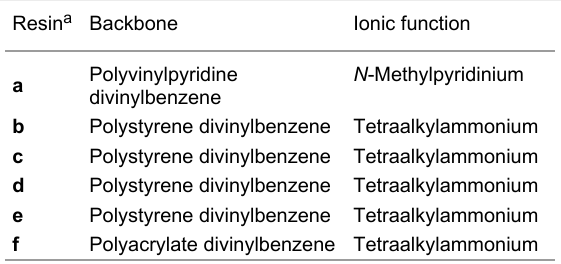
Even in batch processes it was possible to remove more than 90% of dissolved 1 from the model solution which indicates that strong interactions between the resins and the adsorptive phase takes place. Desorption of the product can easily be performed by acidic treatment of the loaded resins. The most AcOH (ratio 8:2). This treatment leads to protonation of vanil- late anions adsorbed at the resin and ionic interactions between the resin and the product vanish. The remaining interactions between vanillin ( 1 ) and the aromatic backbone are not strong